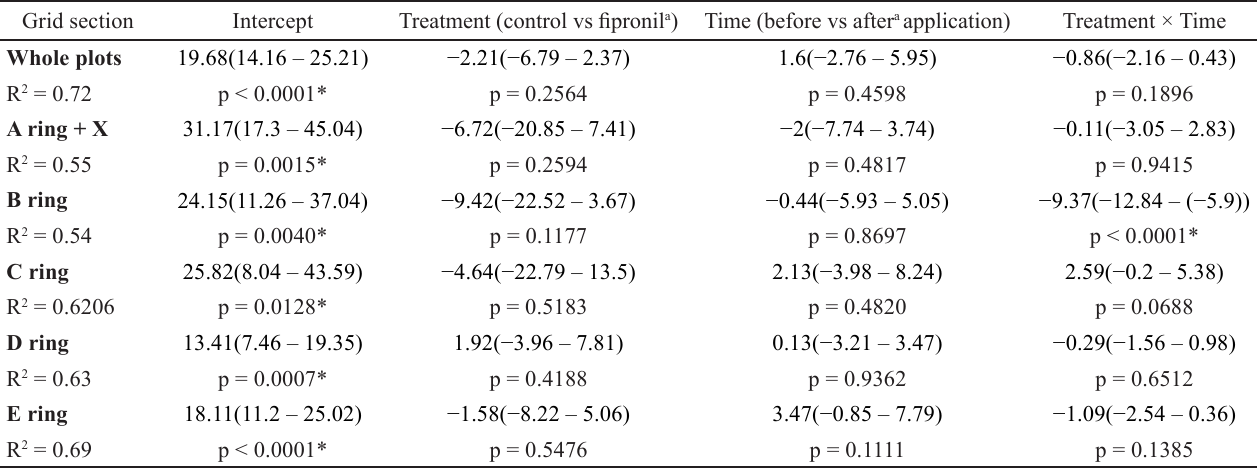
a The levels of categorical variables used as a base for comparisons were “fipronil” for the treatment variable and “after” for the time with respect to application. * Significant at p < 0.05.